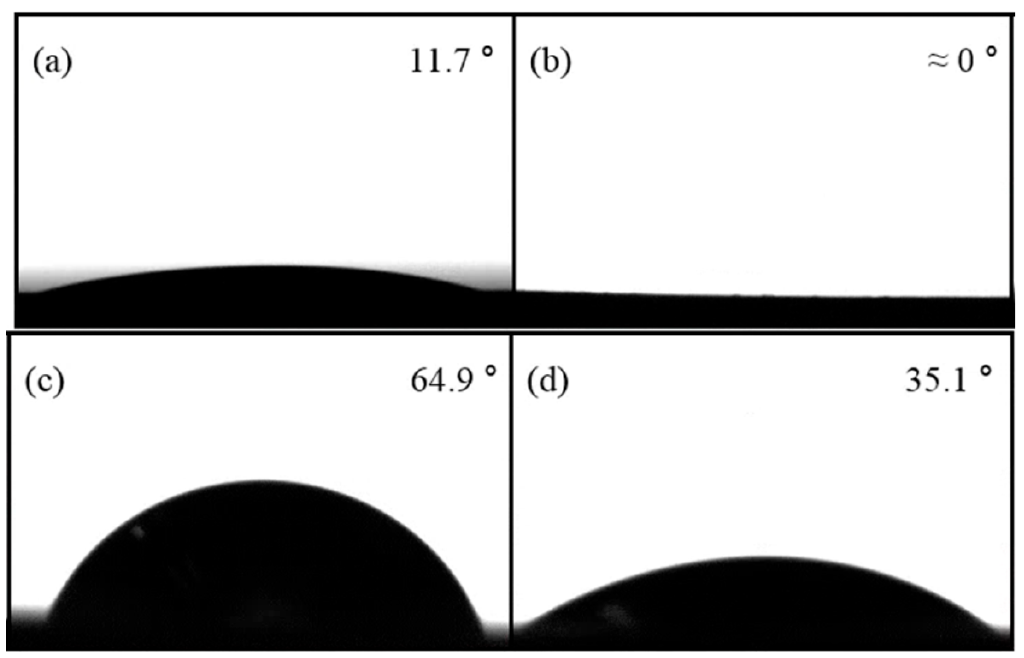
Figure 8. Contact angles of each surface: ( a ) the short micro-patterned surface; ( b ) the tall micro-patterned surface; ( c ) the plain copper surface; and ( d ) the flat copper surface fabricated by powder injection molding (PIM) with no micro-patterns.